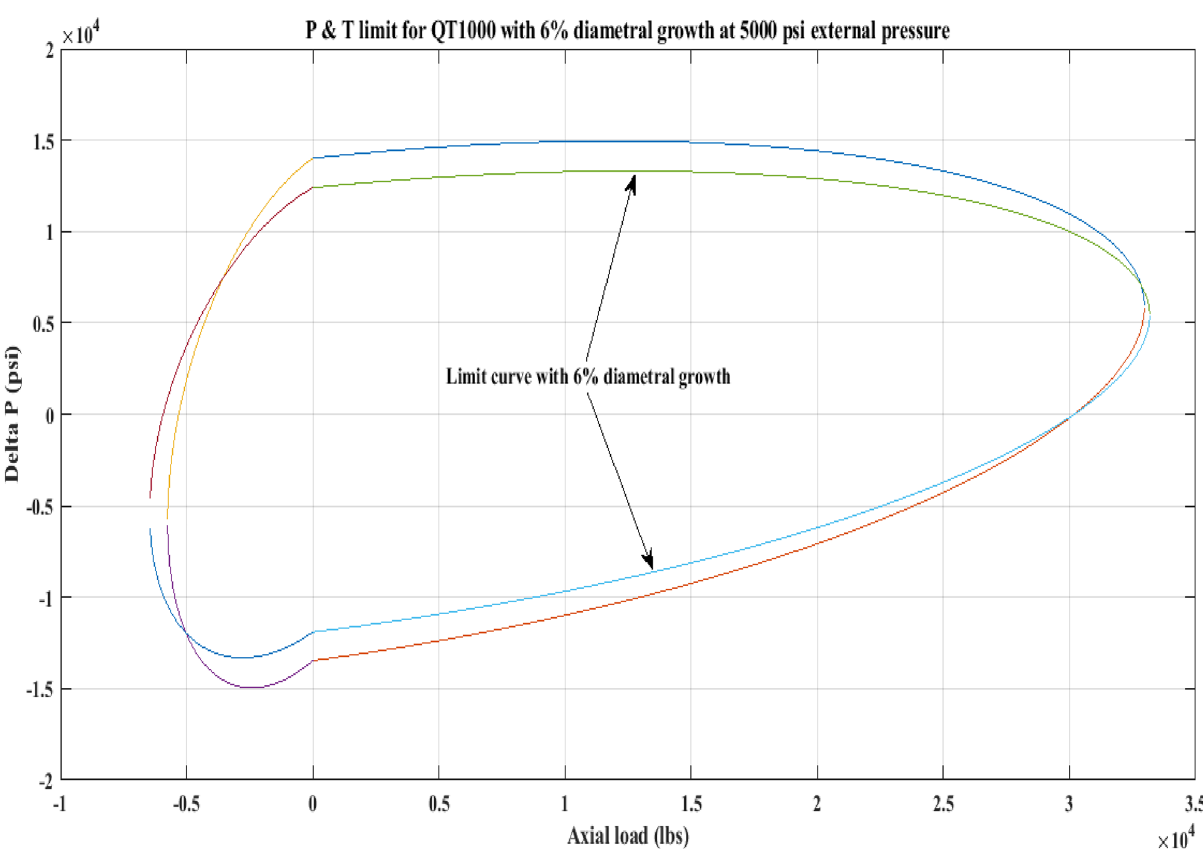
Figure 15. P and T limit with diameter growth for QT 1000 at 5000 psi P o